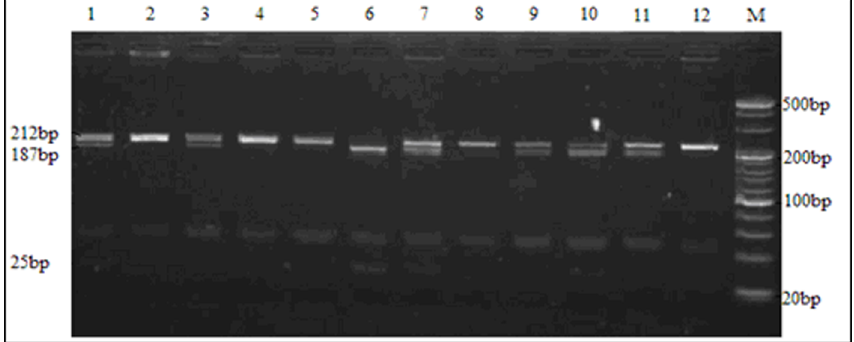
Figure 1. Determination of the rs10507391 genotype by PCR amplification and restriction analysis. When the nucleotide A is present, a Vsp I restriction site is created. Lane 6: homozygous AA (187 bp and 25 bp). Lane 1,3,7,9–11: heterozygous AT (212 bp,187 bp and 25 bp). Lane 2,4,5,8,12: homozygous TT (212 bp). Lane M: DNA marker.